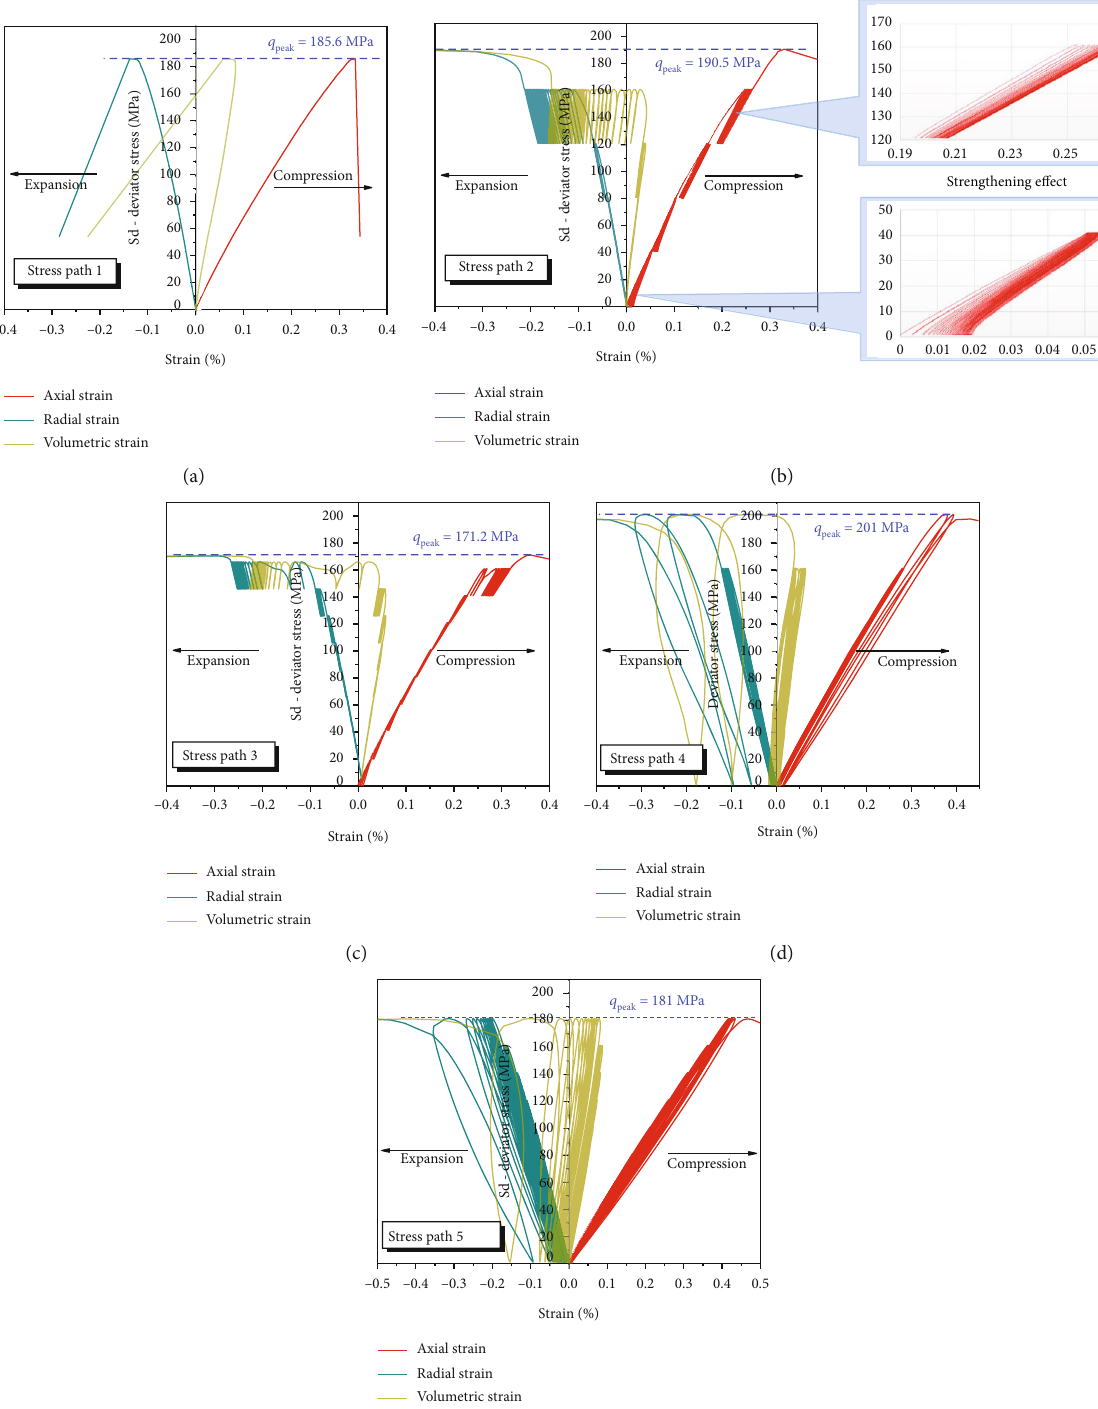
Figure 4: Stress-strain curves of limestone subjected to step cyclic